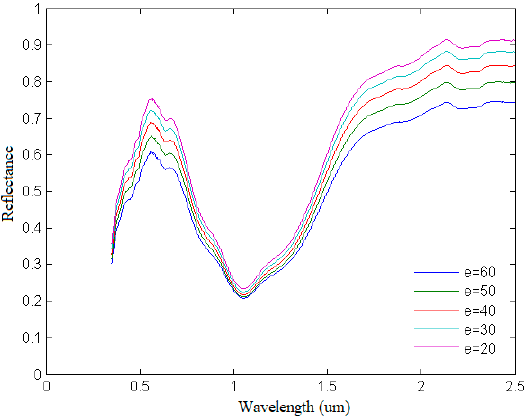
Figure 10. Simulated spectra of olivine.